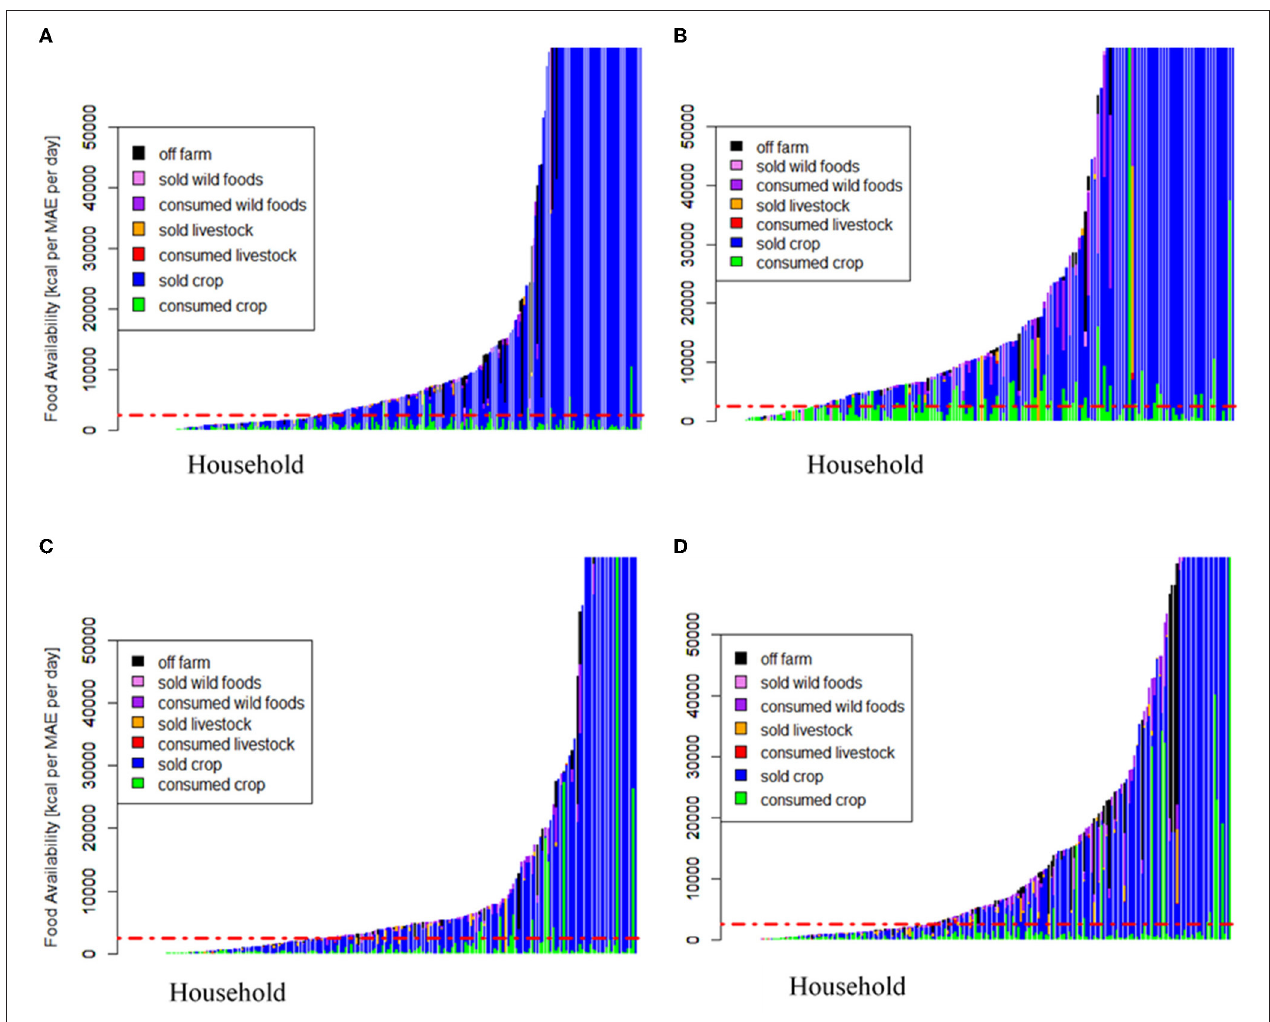
FIGURE 3 | The overall distribution of food availability across all study households in (A) Bouaké [top left], (B) Gagnoa [top right], (C) Ahafo Ano North [bottom left], (D) Ahafo Ano South [bottom right]. Each vertical bar represents one household, the colors represent its energy sources, and the height represents total food availability. The red dotted line indicates the minimum energy intake of 2,500 kcal MAE − 1 d − 1 for food security. Thus, 32, 16, 38, and 38% of the households in Bouaké, Gagnoa, Ahafo Ano North, and Ahafo Ano South are below the minimum energy intake,